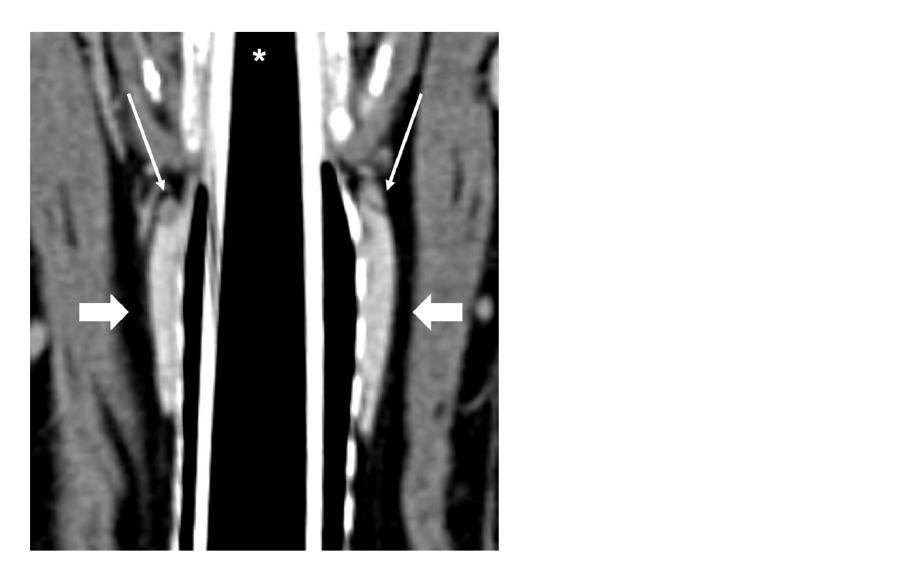
Figure 1. Visualization of a normal right external parathyroid gland in a dog, post-contrast images. Two different 3D image volume techniques were used: multiplanar reformation (MPR), in which the three orthogonal imaging planes are seen ( A ) transverse plane; ( B ) dorsal plane; and ( C ) sagittal plane, and volume rendering (VR) technique (parasagittal view) ( D ).